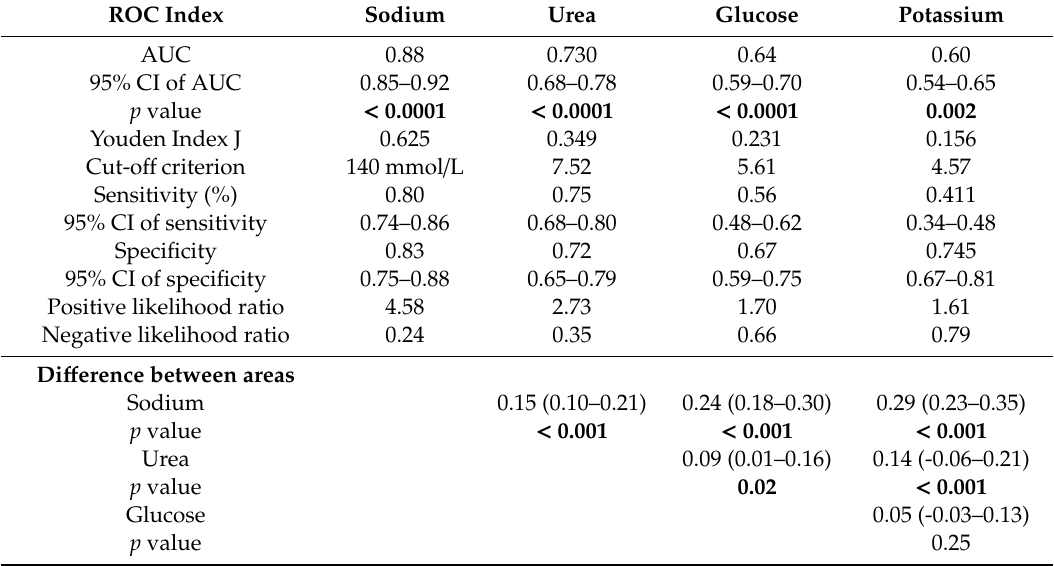
Figure 1. Receiver operating characteristics (ROC) curve analysis for the ability of sodium, urea, glucose, and potassium to predict impending underhydration. Table 2. The values of sodium, urea, glucose, and potassium for the prediction of impending underhydration, and their overall diagnostic effectiveness.